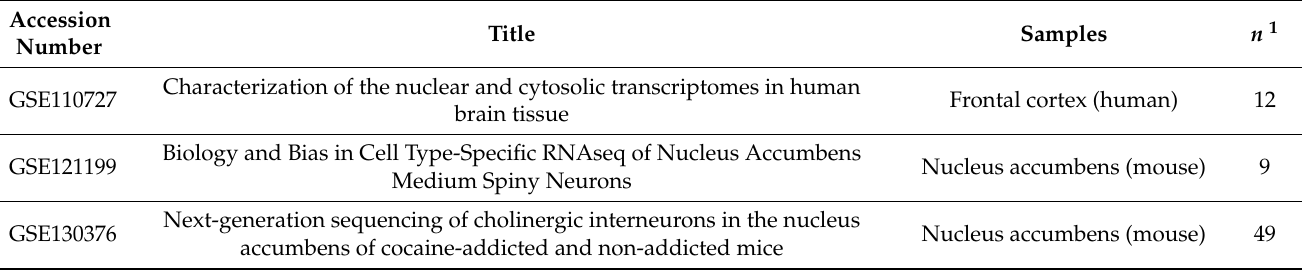
Table 3. Datasets for the specific cellular or subcellular fractions included in the